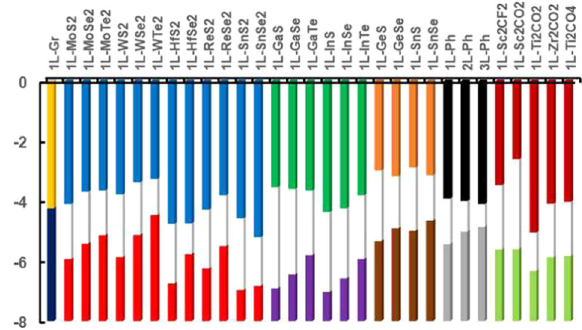
Fig. 21 Comparative Band Alignments of 2D Materials. Plots of the relative band alignments with CBM and VBM position with respect to vacuum-level (E 0 ), for different 2D materials, calculated using Heyd – Scuseria – Ernzerhof-06 (HSE-06) DFT functional 173 – 178 .